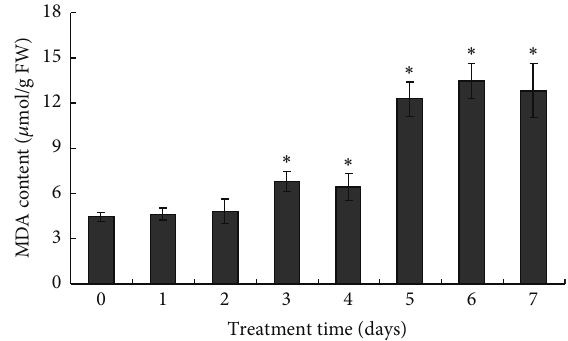
Figure 5: Effect of NaCl on MDA content of L. sinense seedlings. Values are means ± SD ( 𝑛 = 3 ). ∗ Significant difference between NaCl-treated and untreated sample ( 𝑃 < 0.05